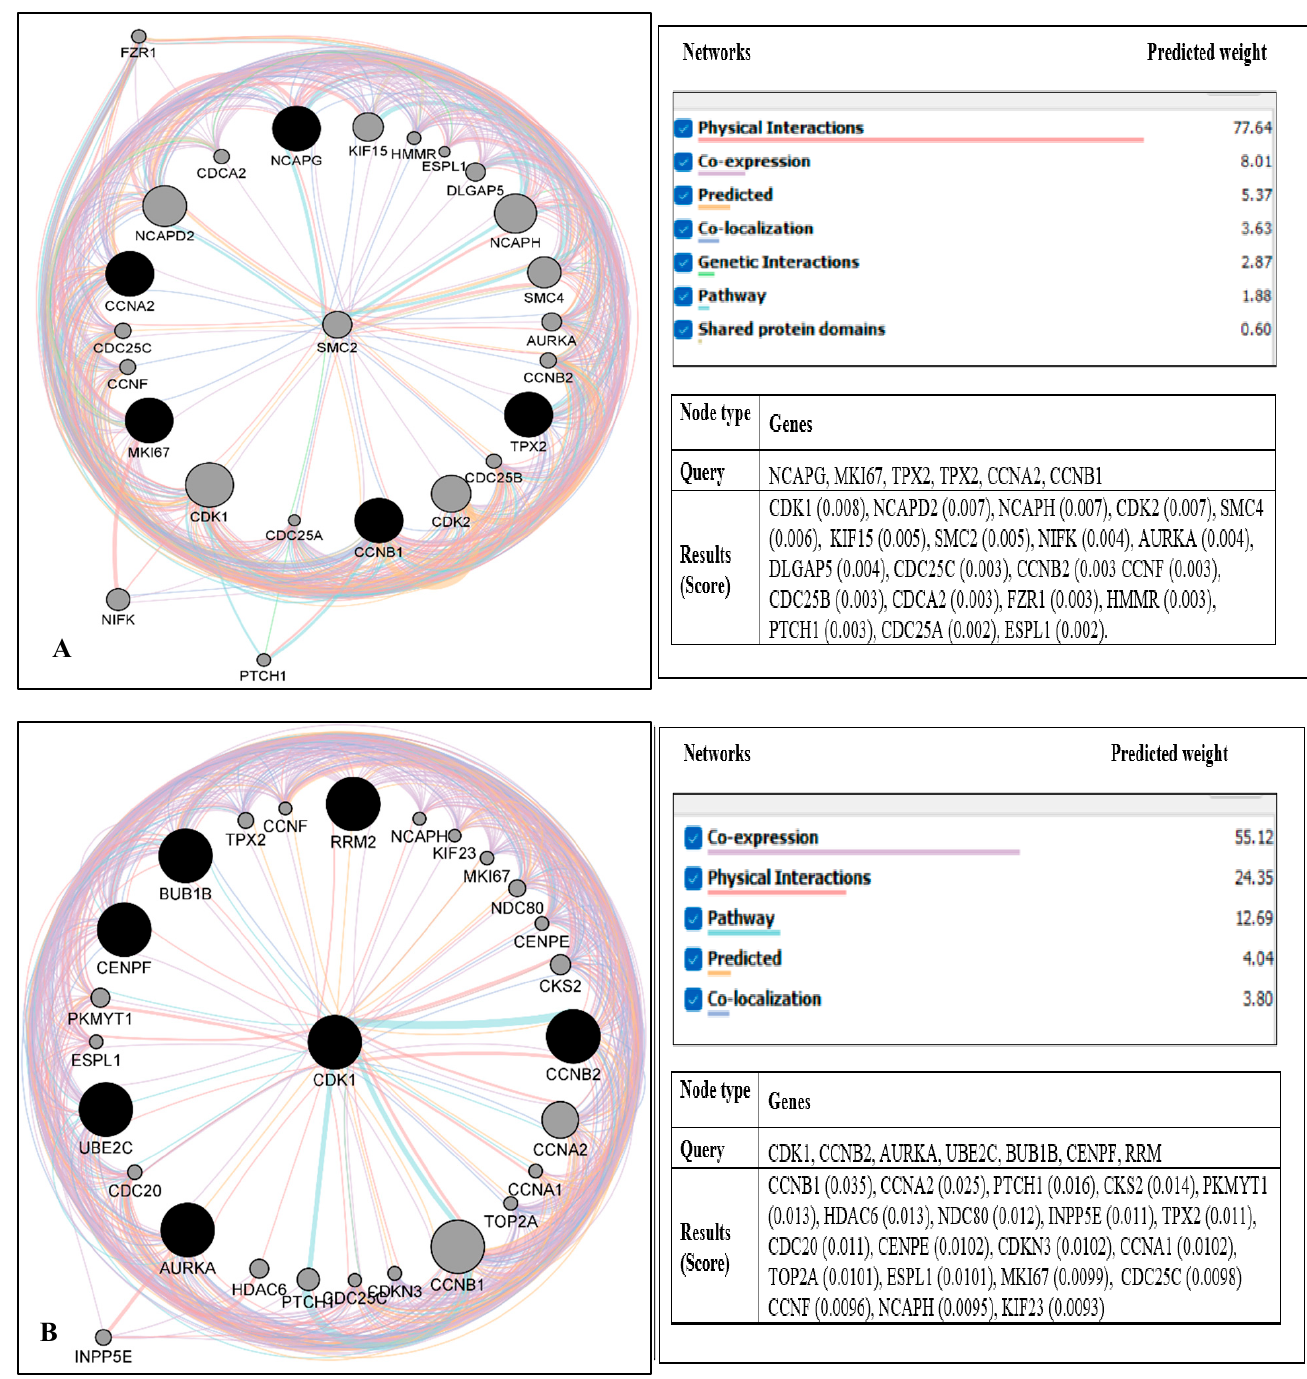
Figure 5. The network of hub genes (black circle), their related genes (gray circle), and the predicted weight percentages of the networks (physical interaction, co-expression, co-localization, genetic interaction, pathway, and shared protein domain) generated by GeneMANIA: ( A ) up-regulated hub genes with 25 genes were discovered with up-regulated genes and ordered with their score (circle size), and ( B ) down-regulated hub genes with 27 genes were discovered with down-regulated genes and ordered with their score (circle size).